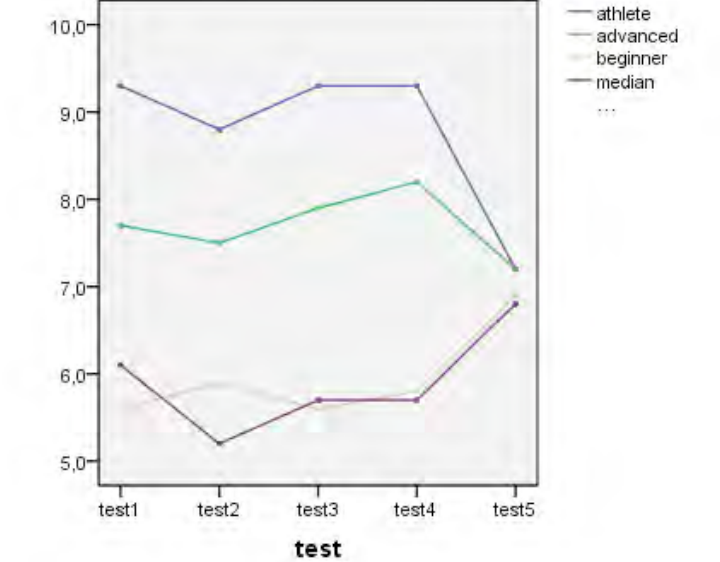
Figure 3. Resulting score of 5 tests - criteria in relation to the plane of the